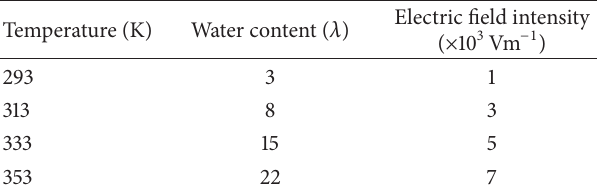
Table 1: Values of the operating conditions used in the